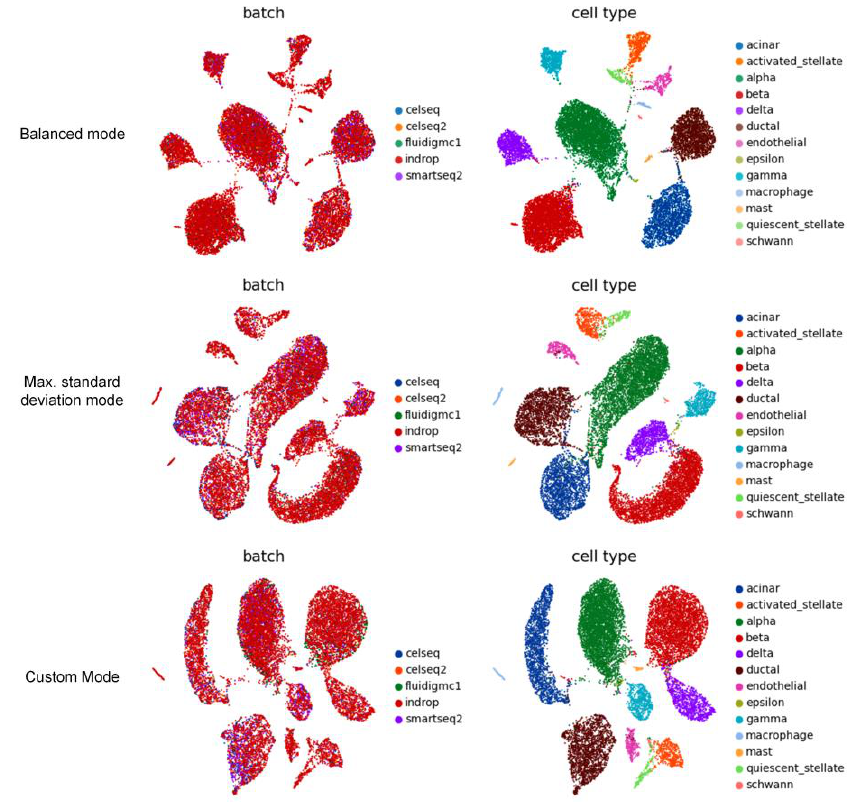
Figure 13. UMAP visualization of the Pancreas dataset corrected by IMAAE using three different anchor batch modes. Table 2. Quantitative assessment of the correction results for three anchor batch models using ASW, ARI, NMI, and corresponding F1 scores.